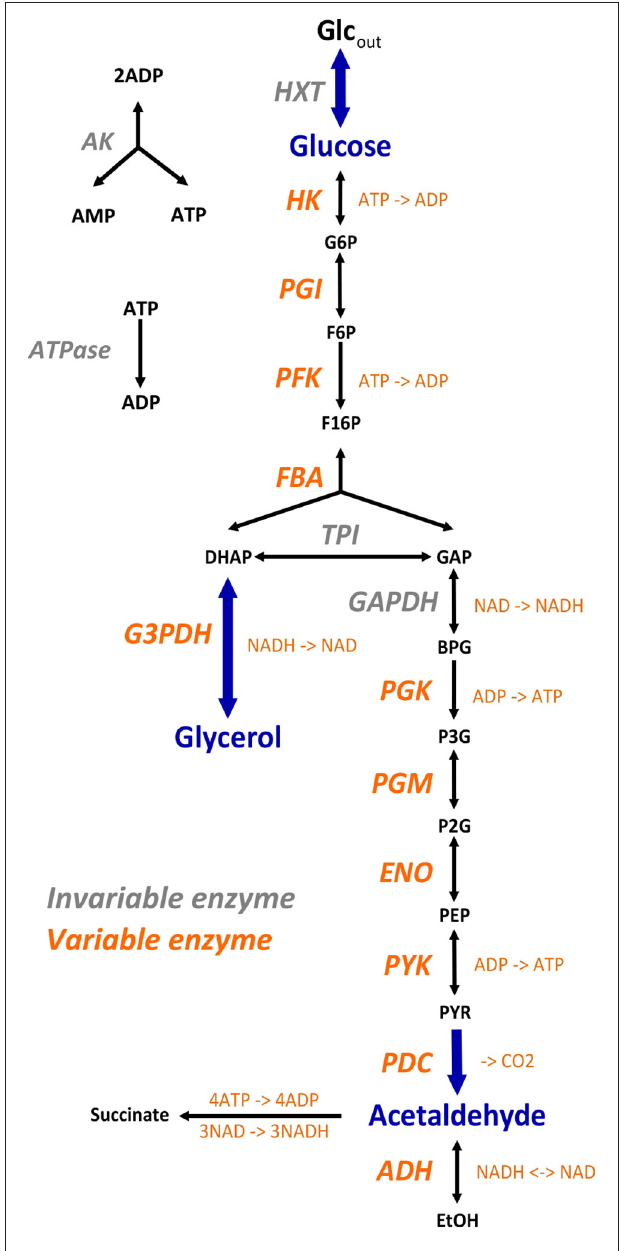
FIGURE 3 | The simplified yeast glycolysis/fermentation network. Variable enzymes are in orange. Blue arrows point to the input flux, glucose, and to the output fluxes, glycerol and acetaldehyde.